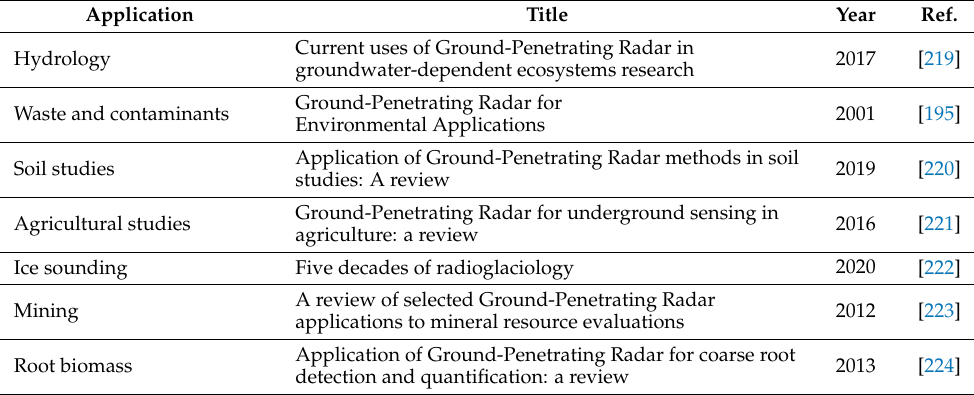
Table 4. Published review papers in environmental